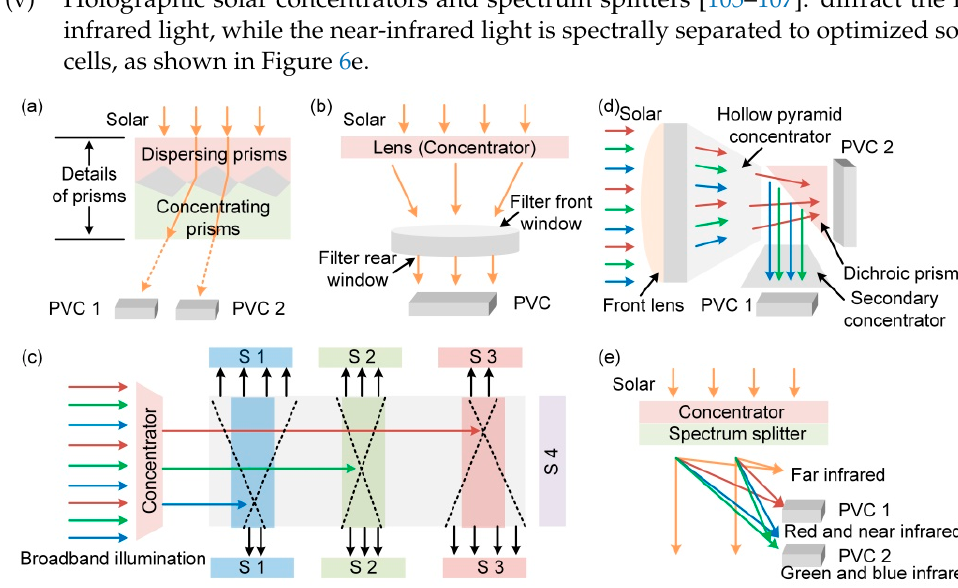
Figure 6. Schematic of ( a ) refractive spectrum-splitting module of prism arrays and PVC arrays, and details of prism arrays, ( b ) filter, ( c ) luminescent spectrum splitter, ( d ) fabricated dichroic mirrors, and ( e ) holographic concentrator and spectrum splitter.